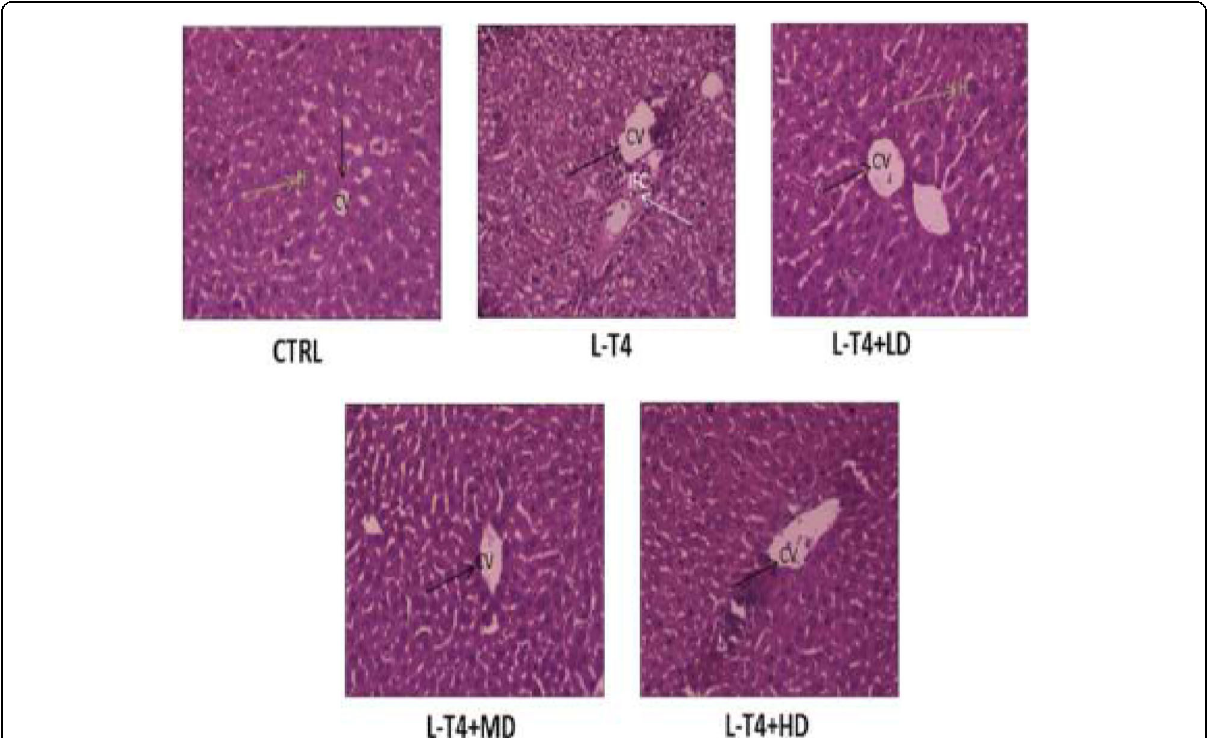
Fig. 5 Effects of ACC on the liver histology. While control (CTRL) animal showed normal liver architecture, in L-T4 induced mice severe centrilobular damage and cell necrosis were seen. L-T4 + low dose of ACC showed almost normal histological features. In hyperthyroid animals, treatment with medium dose of ACC exhibited moderate liver damage and its high-dose administration showed cellular and central vein